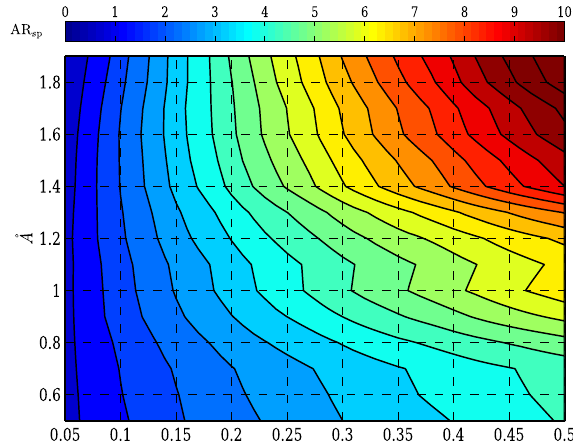
Figure 2. Colors represent AR sp (calculated as AR sp = N CCN at 450nm wavelength and 0.07% supersaturation) with different PNSDs (classified by Å values) and different κ c . Figure 3. The schematic chart of the N